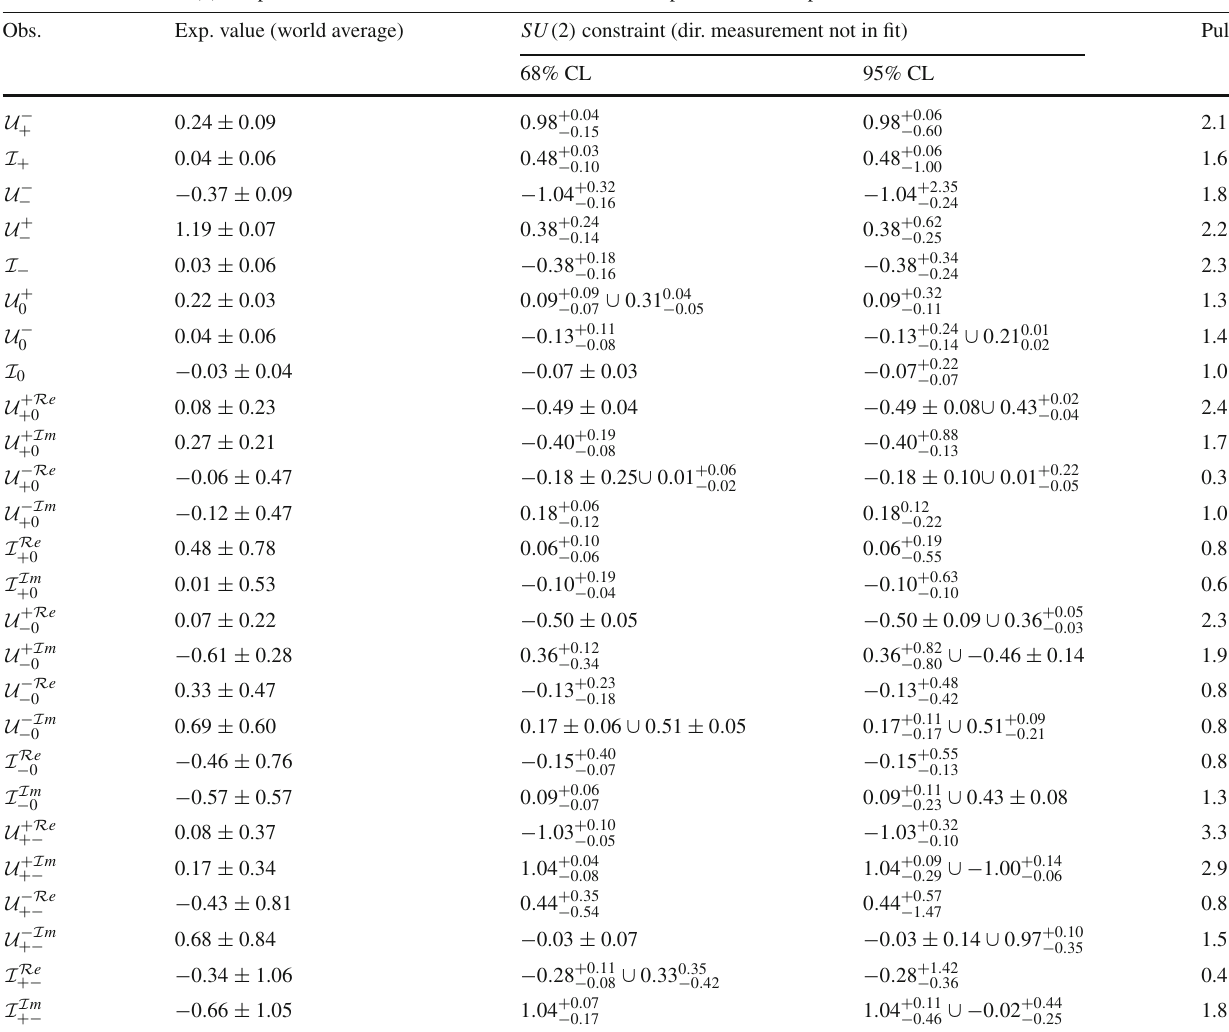
Table 17 Indirect SU ( 2 ) isospin determination of the U and I coefficients compared to their experimental measurement